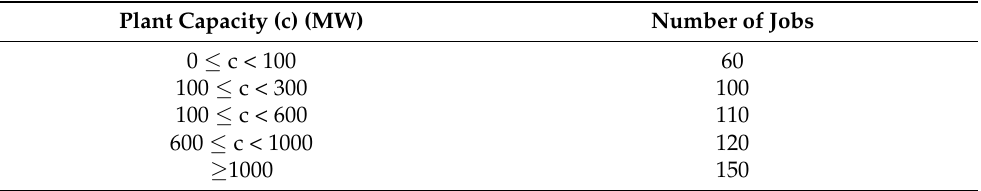
Table A10. Number of jobs in coal plants by plant capacity. Adapted from